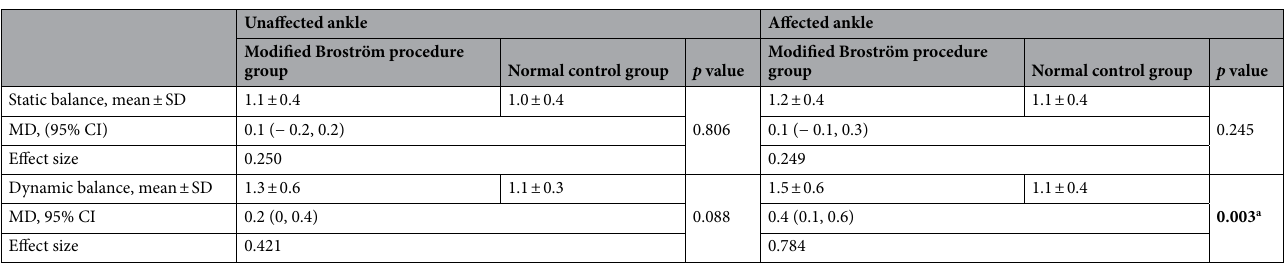
Table 2. Postural stability between the modified Broström procedure and normal control groups. Significant values are in bold. Values expressed as mean ± standard deviation. The measurement units for the balance test was the degree. SD Standard deviation, MD mean difference, CI confidence interval. a Statistically